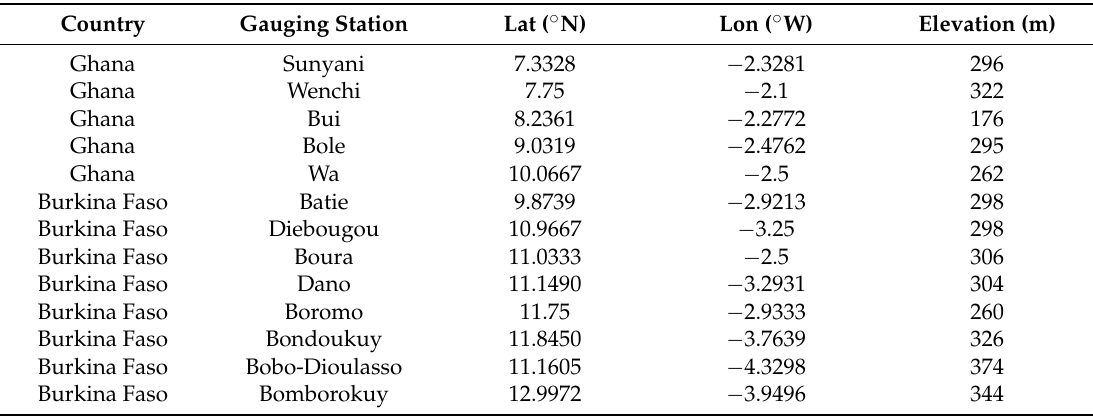
Table 1. General characteristics of the study stations and their country